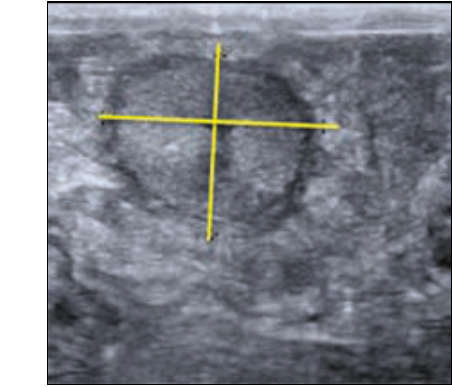
Black arrow- Endometrial cell Red arrow- PMN cells Fig. 2 Transrectal ultrasonography